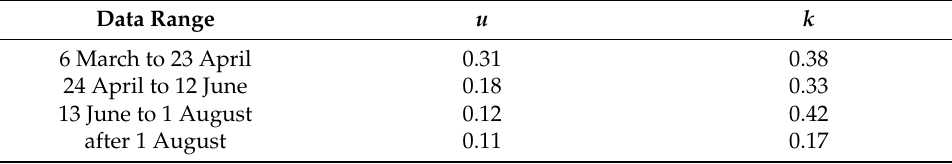
Table A5. The set value for the hospitalization fraction ( u ) and dead fraction ( k